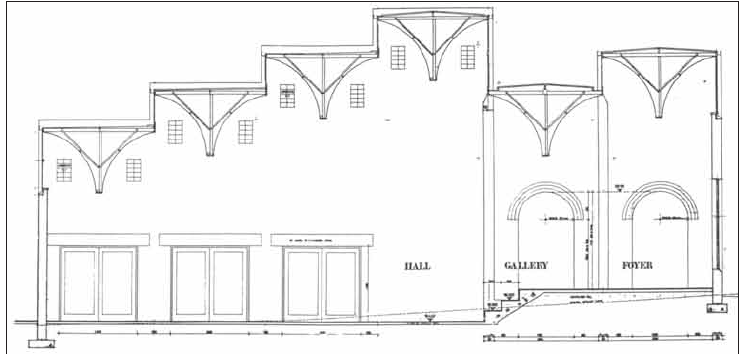
Figure 10: Steinkopf Community Centre,